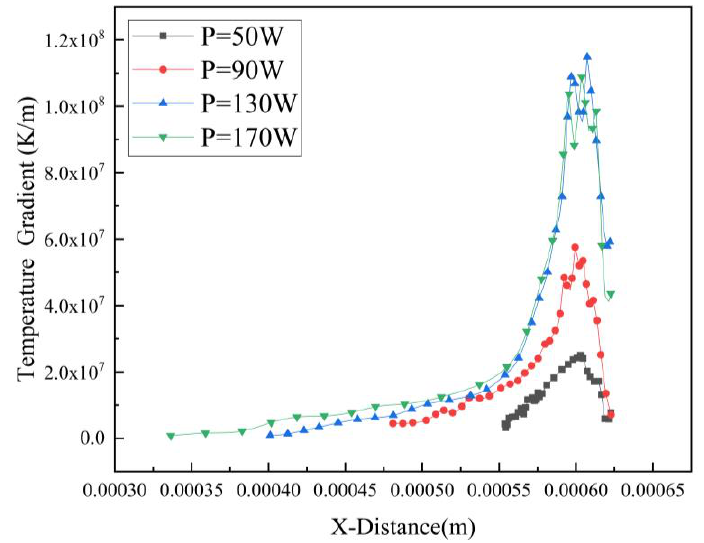
Figure 10. The temperature gradient in the X direction of the molten pool during the ILP process with four processing parameters.